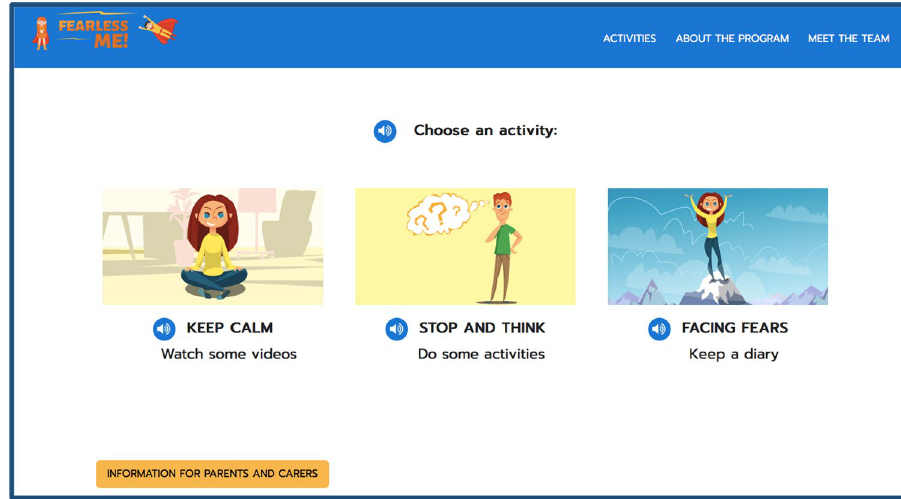
Fig. 1 The three modules on the Fearless Me! © website, teaching children relaxation strategies, providing cognitive challenging exercises and facilitating exposure